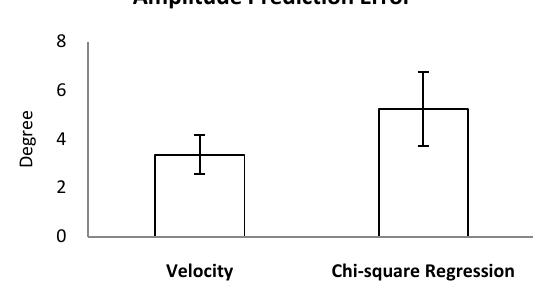
Figure 2. Saccade amplitude prediction errors by the two models based on average RMSE Also, the scatter plots of actual saccade amplitude